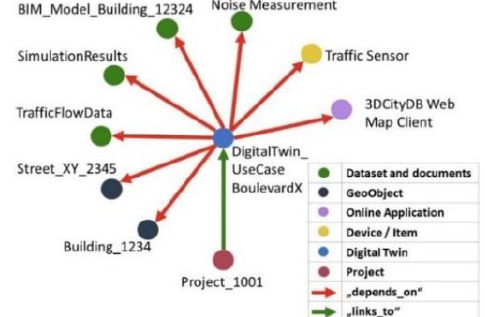
Figure 5: Visual exploration of an UDT represented by linked catalog entries in the CKAN user interface